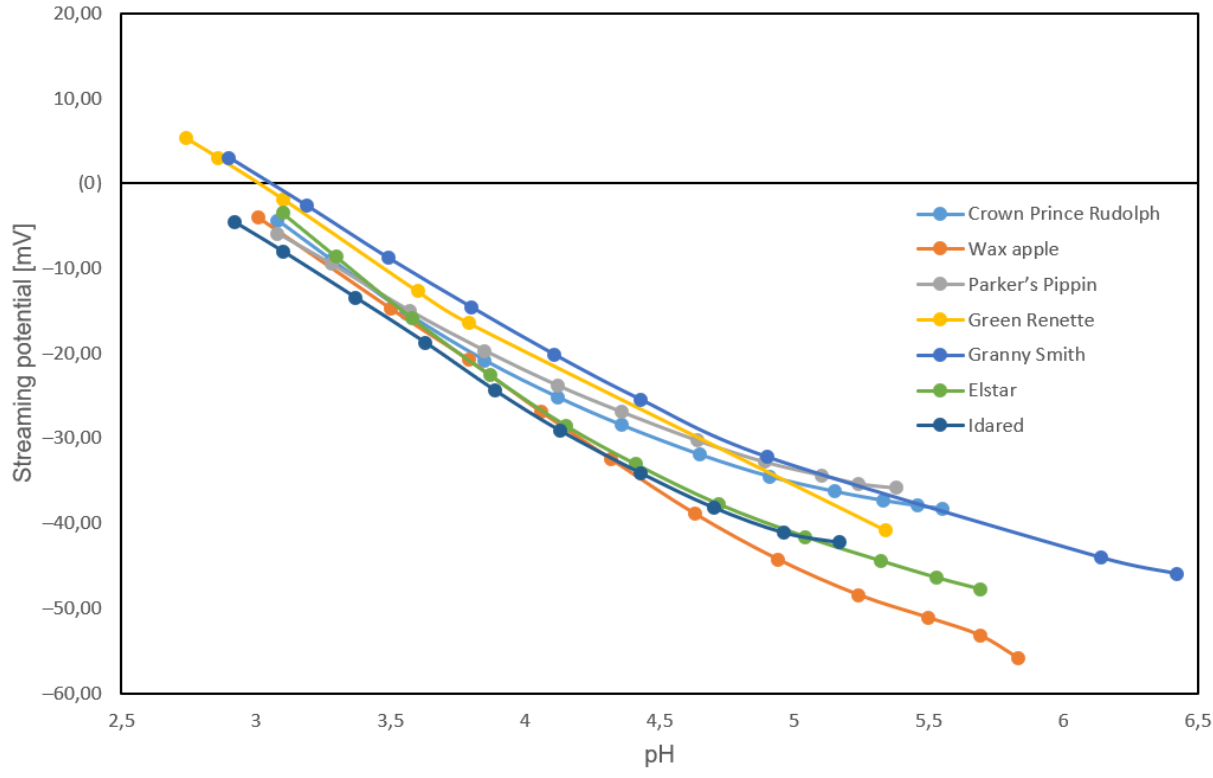
Figure 4. Zeta potentials of all cultivars as a function of pH (measured on the equatorial region). Autochthonous apple cultivars: Crown Prince Rudolph, Wax apple, Parker’s Pippin and Green Re- nette; commercial cultivars: Granny Smith, Elstar and Idared.